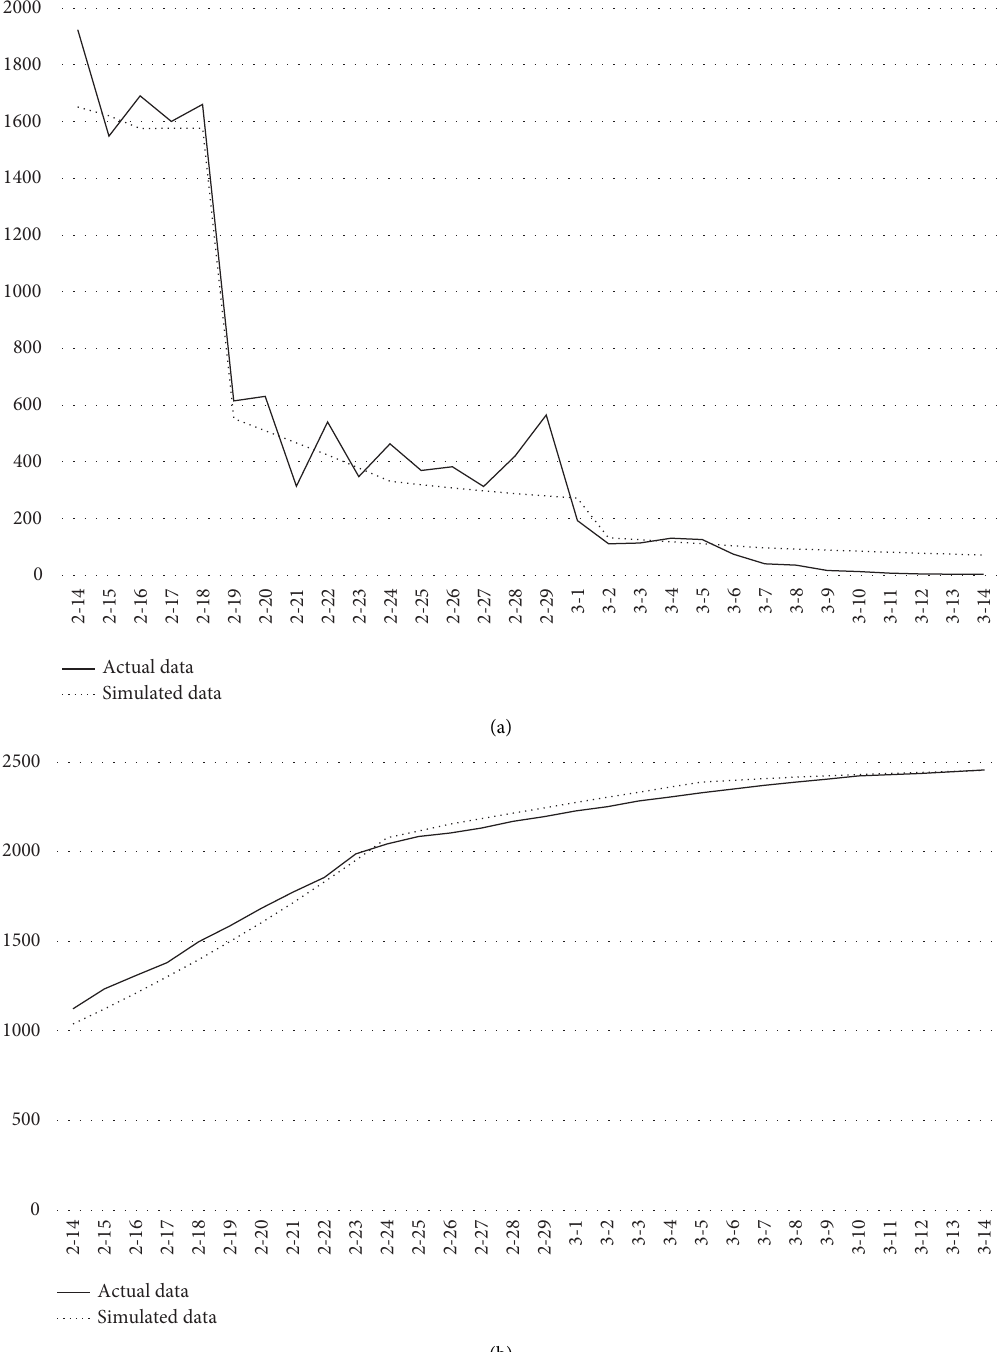
Figure 8: Comparison of simulated and actual data of the COVID-19 in Wuhan. (a) The number of confirmed cases in every single day. (b) The cumulative number of